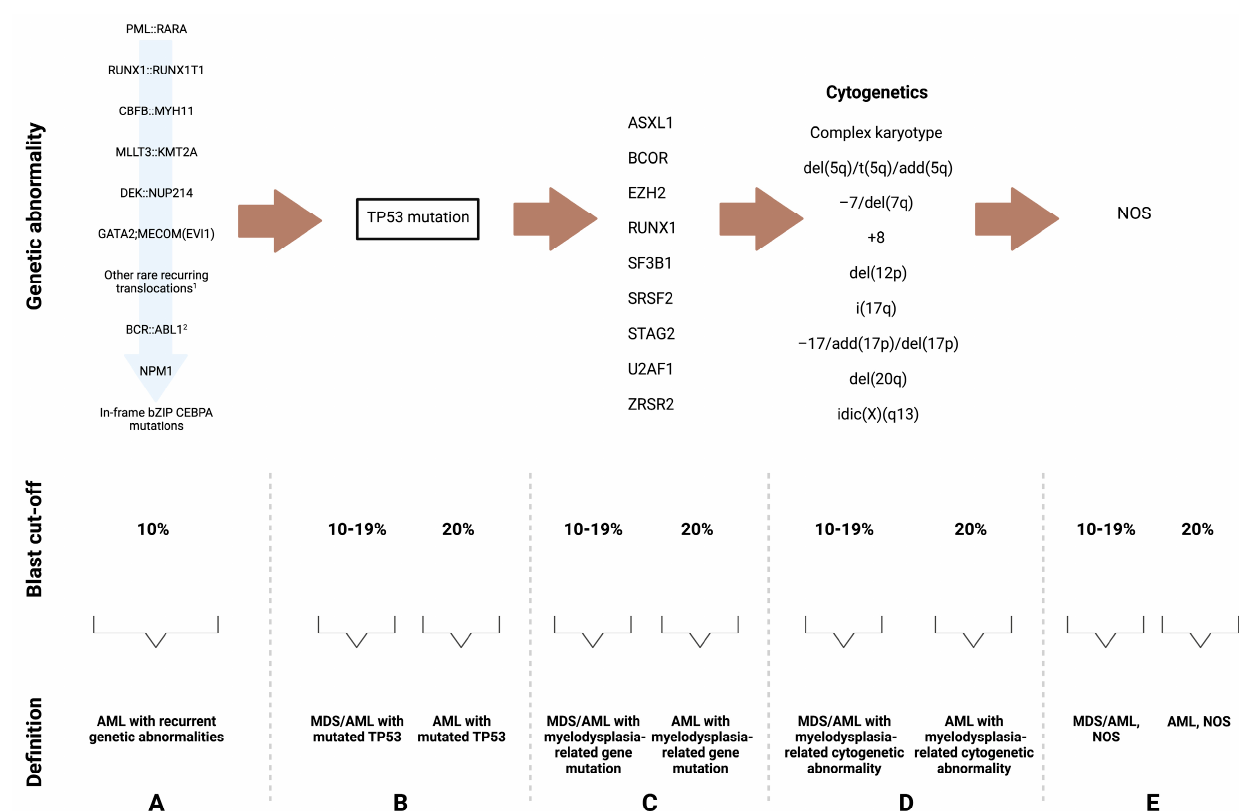
Figure 2. The classification algorithm of AML based on the new changes. ( A ) AML with recurrent genetic abnormalities takes precedence in the diagnostic algorithm, and the blast cut-off for diagnosis is lowered to 10%, with the exception of BCR::ABL-mutated AML. Within this group, PML::RARA mutations supersede RUNX1::RUNX1T1 mutations, followed by CBFB:MYH11, then MLLT3:KMT2A, then DEK::NUP214, then GATA2;MECOM(EV11), followed by other rare recur-